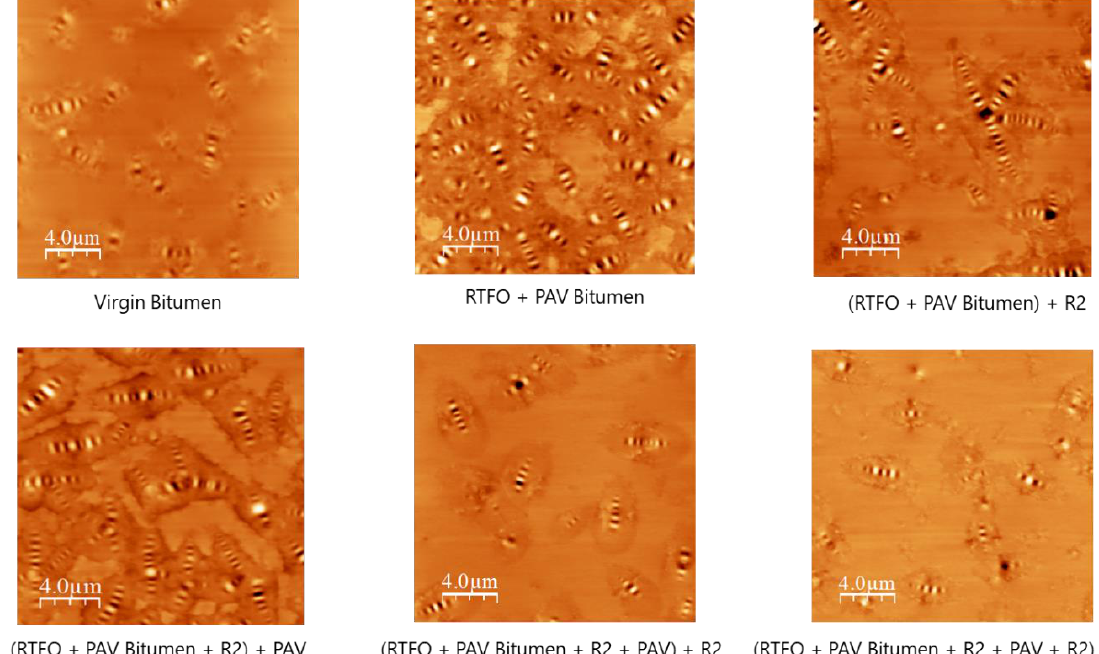
Figure 4. AFM images of virgin, aged, and R2-modified samples.